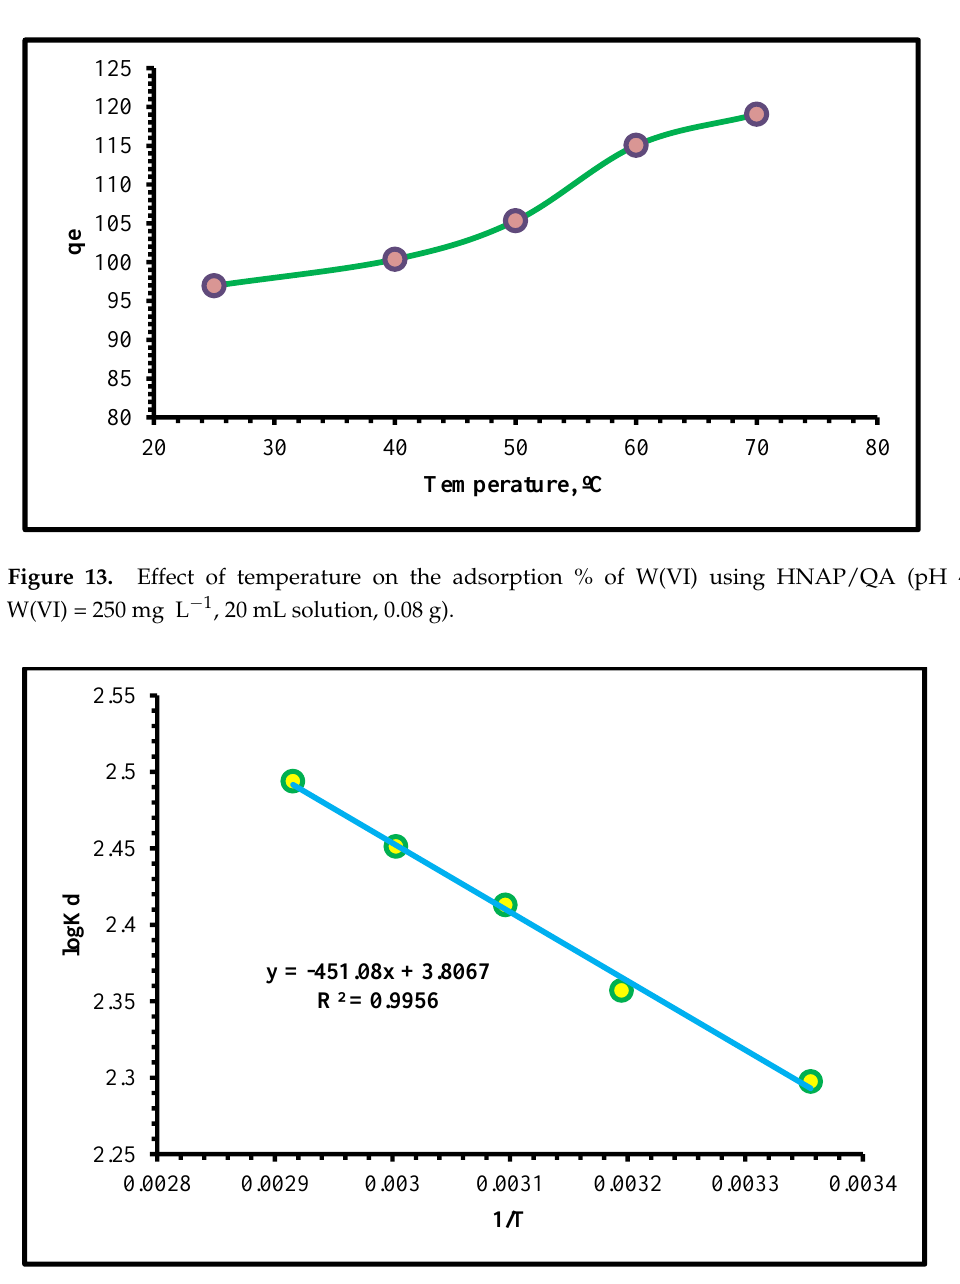
Table 4. Thermodynamic parameters of W(VI) ions adsorbed on HNAP/QA.